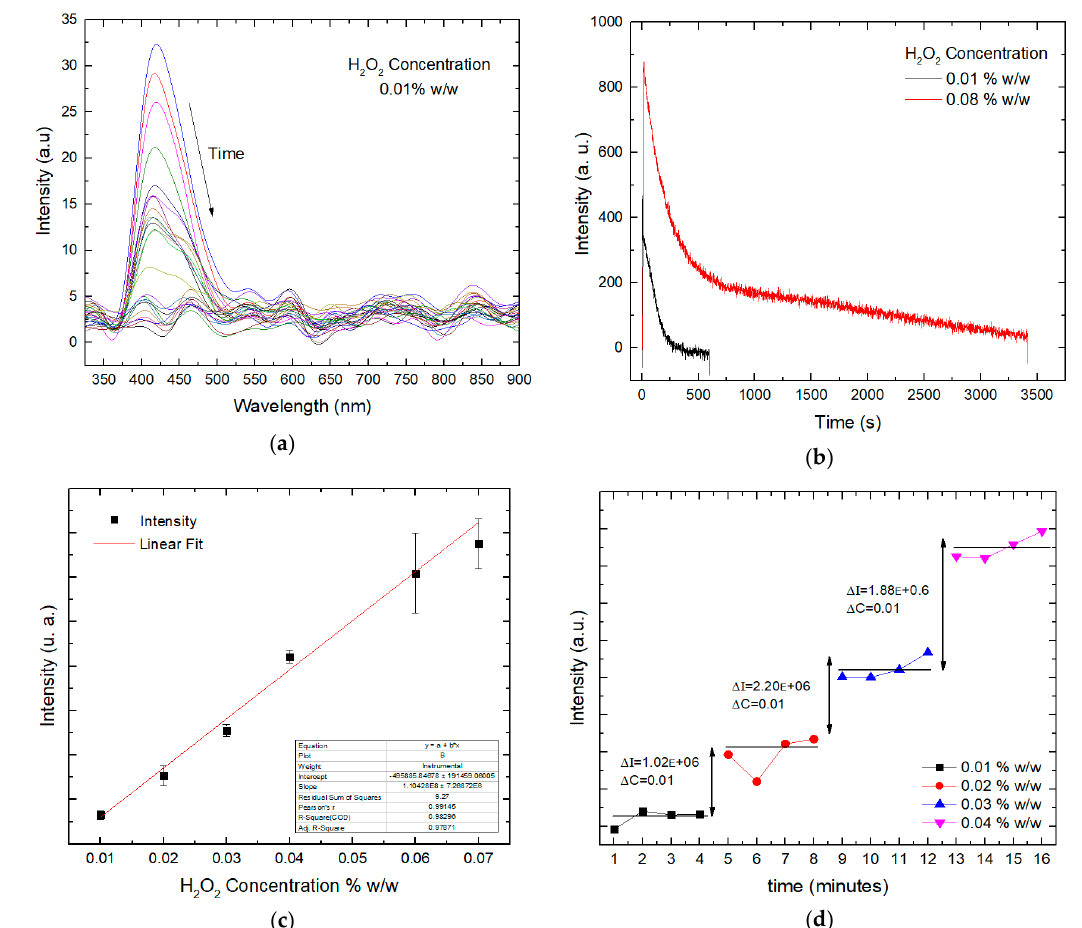
Figure 1. ( a ) Spectra showing the variation of the intensity of the light emission to the concentration 0.01%w/w as a function of the reaction time; ( b ) decay time of the spectra integral as a function of the chemical reaction; ( c ) integral of the decay time for each H 2 O 2 concentration; ( d ) measured intensity when the H 2 O 2 undertakes step